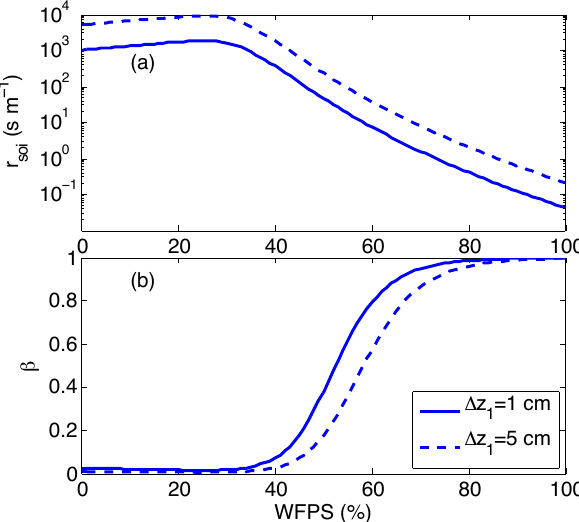
Figure 7 The effect of using different parameterizations of soil hydraulic properties 2 Fig. 7. The effect of using different parameterizations of soil hy- draulic properties (extended Clapp and Hornberger (CH-SG) and (extended Clapp and Hornberger (CH-SG) and extended van Genuchten (VG-SG)) on the 3 extended van Genuchten (VG-SG)) on the computed soil resistance computed soil resistance and the corresponding soil evaporation efficiency for the soils 4 and the corresponding soil evaporation efficiency for the soils listed in Table 5. For all cases, these curves are calculated by assuming listed in Table 5. For all cases, these curves are calculated by assuming r r a = 50sm − 1 , D 0 = 2 . 4 × 10 − 5 m 2 s − 1 , and 1 z 1.75 cm. 6 D 2.4 ! 10 " 5 m 2 s -1 , and ! z 1 = 0 =